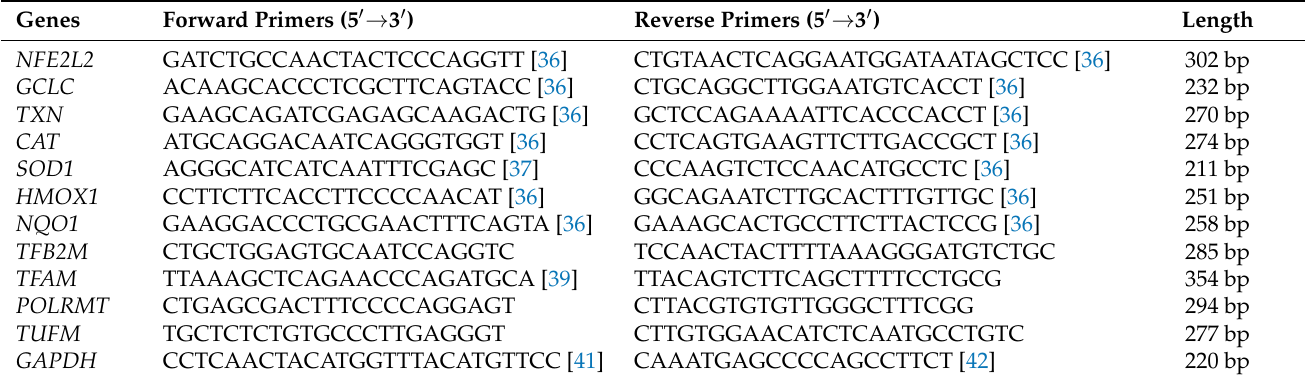
Table 1. Primer sequences and amplicon lengths for antioxidant- and mitochondrial biogenesis-related genes. Genes